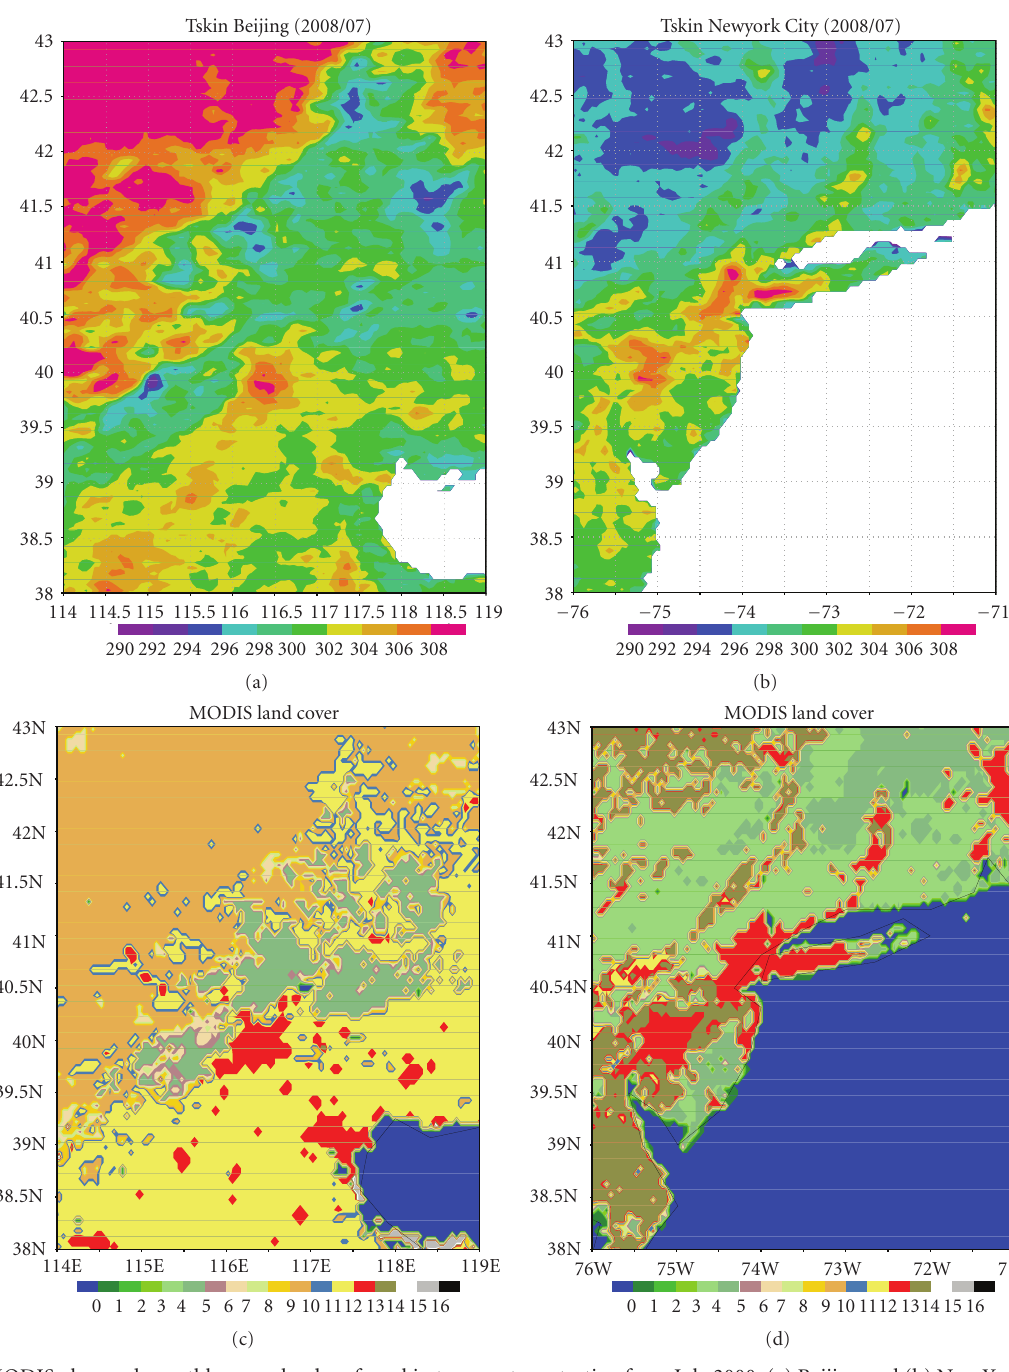
Figure 1: MODIS observed monthly mean land surface skin temperature starting from July 2000. (a) Beijing and (b) New York City (NYC). (c) is land cover map for Beijing region and (d) is land cover for New York City region. The land cover is defined by MODIS as (1) evergreen needleleaf forest, (2) evergreen broadleaf forest, (3) deciduous needleleaf forest, (4) deciduous broadleaf forest, (5) mixed forest, (6) closed shrubland, (7) open shrubland, (8) woody savannas, (9) savannas, (10) grassland, (11) permanent wetland, (12) cropland, (13) urban and builtup, (14) cropland/natural vegetation mosaic, (15) snow and ice, (16) barren or sparsely vegetated. In addition, 0 is